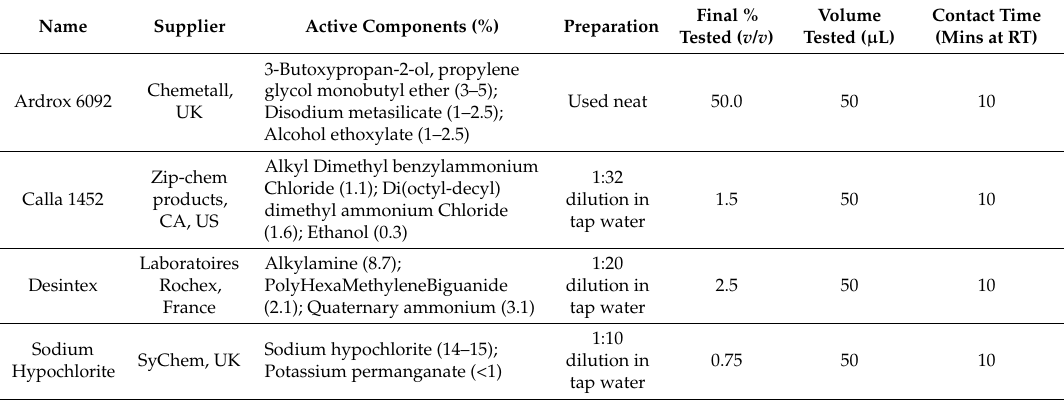
Table 1. Summary of disinfectants assessed for efficacy against Ebola virus